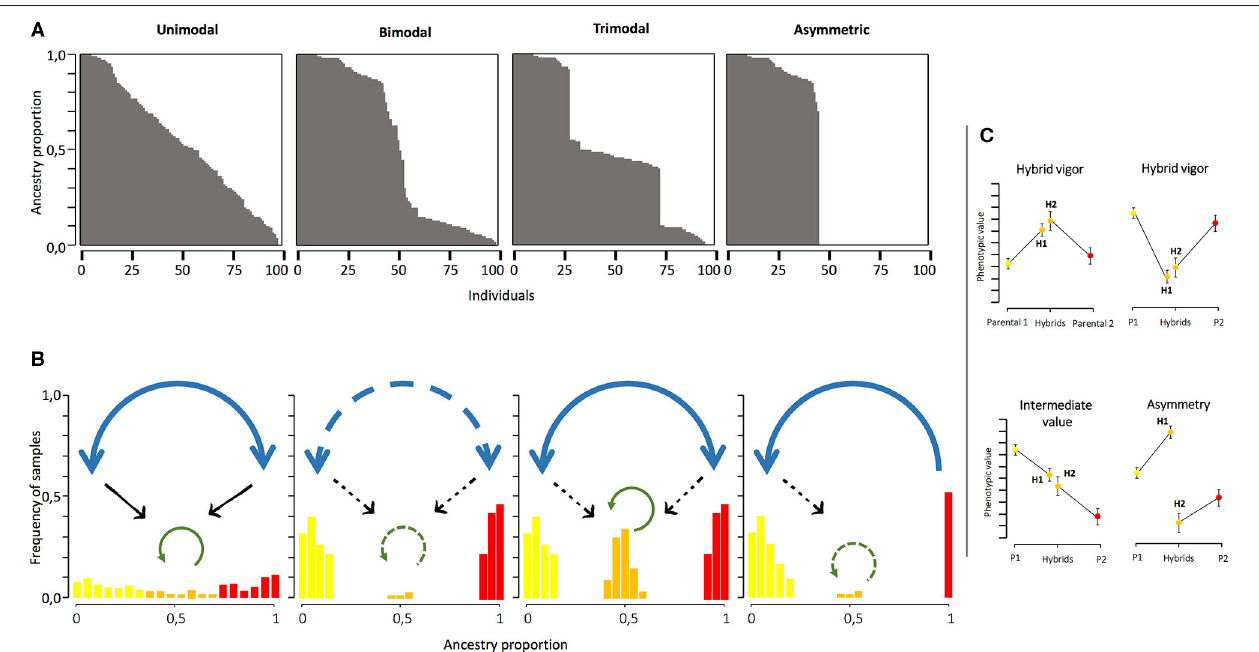
FIGURE 1 | (A) Different models of hybrid zones based on the different patterns of the genetic mixture between divergent taxa. The abscissa axis shows individuals in the hybrid zone and the ordinate axis shows the ancestry proportion exhibited by individuals. (B) Frequency of each range of ancestry proportion in the population and the gene flow expected in each situation. Blue, green, and black arrows represent the gene flow promoted by interspecific crosses, backcrosses, and crosses between hybrids, respectively. The persistence of gene flow is indicated by solid lines; the absence of gene flow is indicated by broken lines. (C) Patterns of the phenotypic differentiation expected when differences between hybrids and parental plants are found. H1 and H2 are the hybrids obtained by adding pollen on parental plants 1 and 2, respectively. Yellow and red dots and bars correspond to the parental species, while orange represents hybrid